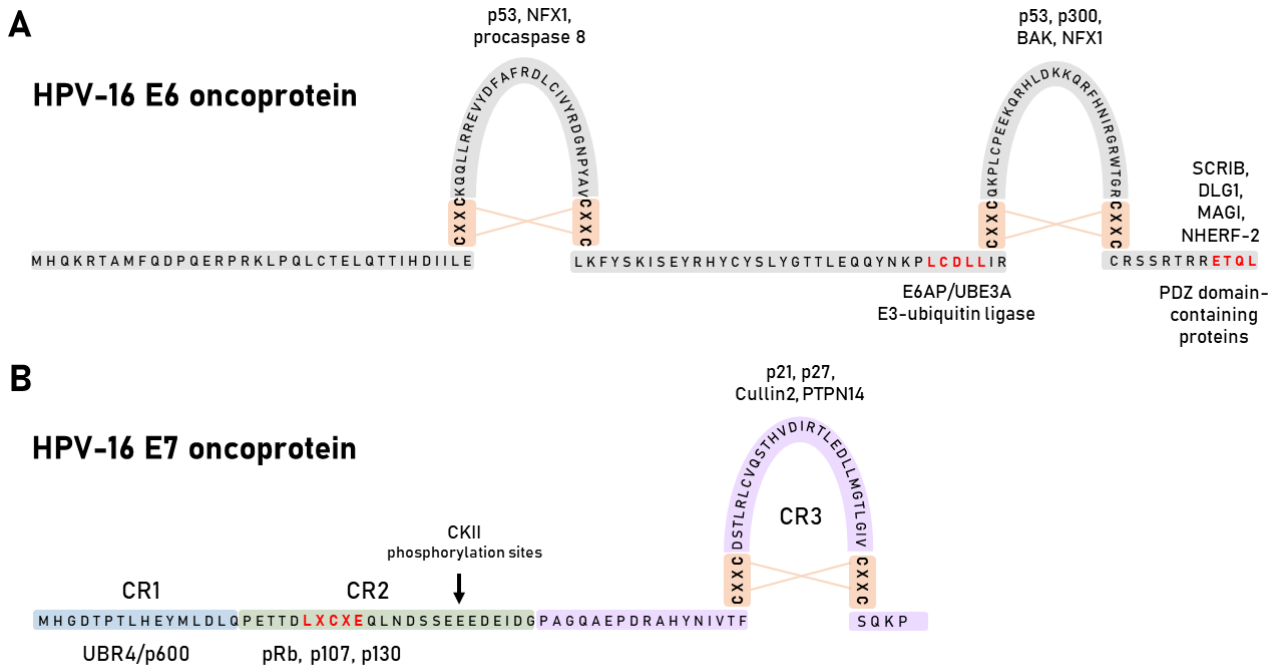
Figure 3. E6 and E7 oncoproteins of HPV-16. ( A ) Schematic representation of HPV-16 E6 oncoprotein amino acid sequence and motifs crucial for E6 protein integrity and activity. HPV-16 E6 contains two zinc finger domains that are involved in a subset of interactions with cellular substrates. Some of the most characterized interacting partners are depicted. ( B ) Schematic representation of HPV-16 E7 oncoprotein amino acid sequence and motifs essential for the oncoprotein stability and function. Three conserved regions of E7 are indicated (CR1-CR3) along with some of their most well-researched interacting partners as well as serines, which are subject to casin kinase II (CKII) phosphorylation, and the zinc-finger region with its interacting partners (adapted from Tomaic, 2016).